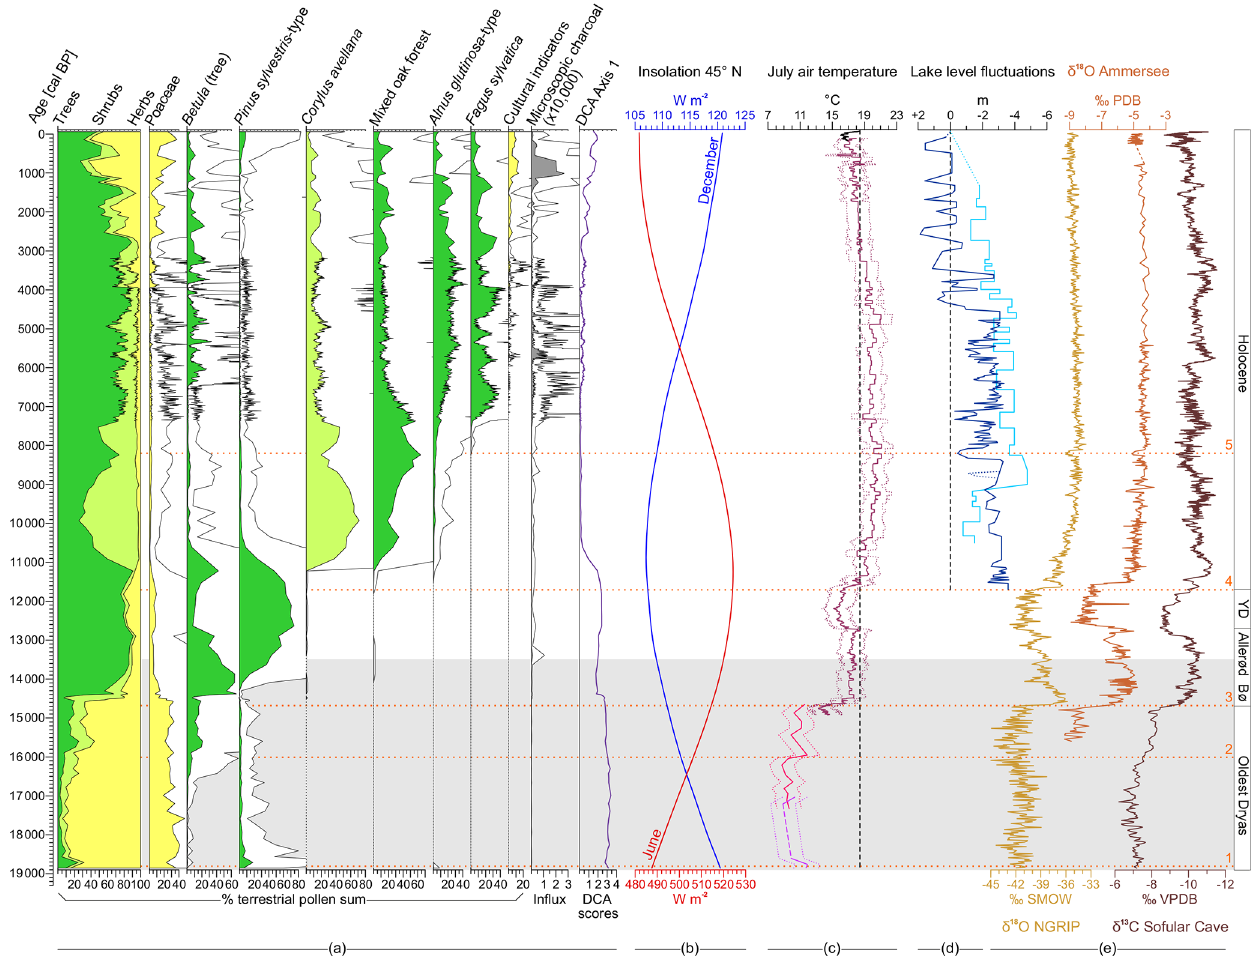
Figure 5. Composite graph. (a) Selected pollen percentages, microscopic charcoal influx values (particles cm − 2 yr − 1 ) and the detrended correspondence analysis (DCA; purple line) of Moossee. Mixed oak forest = (cid:54) Quercus + Ulmus + Fraxinus excelsior + Tilia + Acer . Cultural indicators = (cid:54) Cerealia-type + Plantago lanceolata . Empty curves show 10x exaggerations. (b) June (red line) and December (blue line) insolation for 45 ◦ N (Berger and Loutre, 1991). (c) Mean July air temperature estimates for the altitude of Moossee (521ma.s.l.) using chironomid-based temperature reconstructions from Lago della Costa (light purple lines; Samartin et al., 2016), Lago di Origlio (pink lines; Samartin et al., 2012) and a chironomid-inferred stacked temperature record representing mean July air temperature estimates in the northern and central Swiss Alps (dark red lines; Heiri et al., 2015). Additionally, historical (1755–2018CE) 30-year moving average July air temperature measurements from Basel-Binningen (black line) are shown. Temperatures were corrected under the assumption of a constant modern temperature rate of 6 ◦ Ckm − 1 (Livingstone and Lotter, 1998) and plotted according to Finsinger et al. (2019). The black vertical dashed line indicates today’s average July air temperatures (18 . 3 ◦ C) in Bern-Zollikofen (MeteoSwiss, 2017). The Origlio record is only shown for the oldest part (older than 14600 calBP). Dotted lines reflect standard error estimates. (d) Relative lake level reconstructions of Lac de Cerin (light blue line; Magny et al., 2011) and Lago di Ledro (dark blue line; Magny et al., 2012). The black vertical dashed line marks today’s lake levels. (e) Stable isotopes records from NGRIP (light brown line; North Greenland Ice Core Project members, 2004), Ammersee (dark orange line; von Grafenstein et al., 1998, 1999) and Sofular Cave (brown line; Fleitmann et al., 2009). The horizontal light grey bar indicates the time window of Fig. 4. The orange horizontal dotted lines (1–5) mark important climatic breaks on the basis of temperature changes (Finsinger et al., 2019) and/or increased moisture availability (e.g., Joannin et al., 2013). 1: onset of the Oldest Dryas (19000calBP; Wirsig et al., 2016); 2: post-HE-1 warming (16000calBP; Samartin et al., 2012); 3: onset of the Bølling (14700calBP; van Raden et al., 2013); 4: onset of the Holocene (11700calBP; Heiri et al., 2015); 5: 8.2ka event (8200calBP; Tinner and Lotter, 2001). Bø: Bølling; YD: Younger